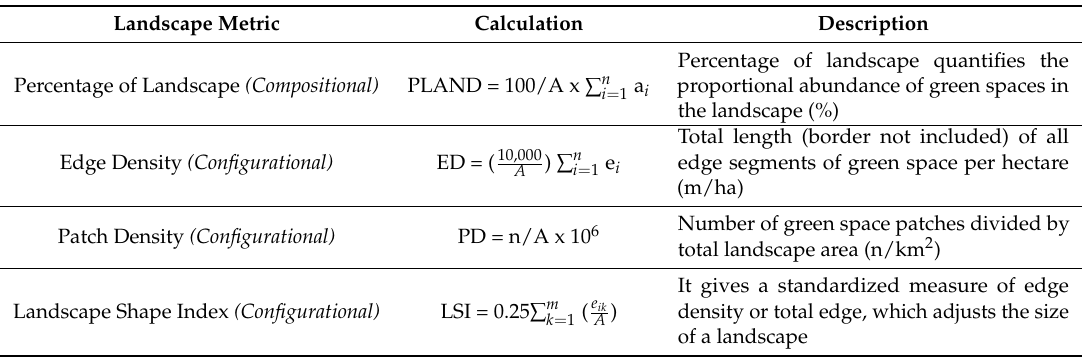
Table 7. Description of landscape metrics calculated for vegetation configuration and